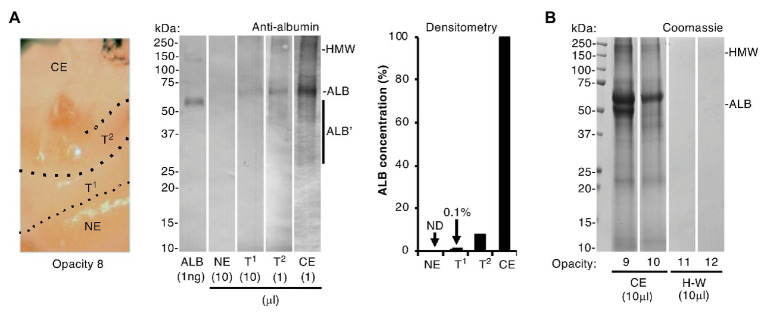
Albumin differentiates chalky enamel from hard-white enamel. Intact chalky and hard-white opacities (opacities 8–10 and 11–12, respectively) were subjected to SDS-PAGE and albumin-immunoblotting (phosphatase detection, with <1 ng sensitivity) as indicated. (A) (Left panel) Photograph showing how opacity 8 was subdissected to provide samples of chalky enamel (CE), visibly normal enamel (NE), and intervening hard-white enamel referred to here as transitional zones 1 and 2 (T1, T2; Mahoney et al., 2004). (Centre panel) Immunoblot analysis, employing differential loads of opacity 8 samples as indicated, showed that albumin was much less prevalent in the transitional hard-white regions nearing the opacity border than in chalky enamel. Albumin fragments (ALB’) and high molecular weight aggregates (HMW) were visible as indicated. (Right panel) Densitometry of the immunoblot showed striking (10–100-fold) differences in albumin content between chalky and transitional enamel as indicated [none detected (ND)]. (B) Coomassie Blue staining showed that hard-white (H-W) opacities 11 and 12 were devoid of albumin, in striking contrast to chalky opacities 9 and 10 (CE), which again exhibited albumin fragmentation and aggregation. This figure was composited from (A) two immunoblots and (B) two Coomassie-stained gels.